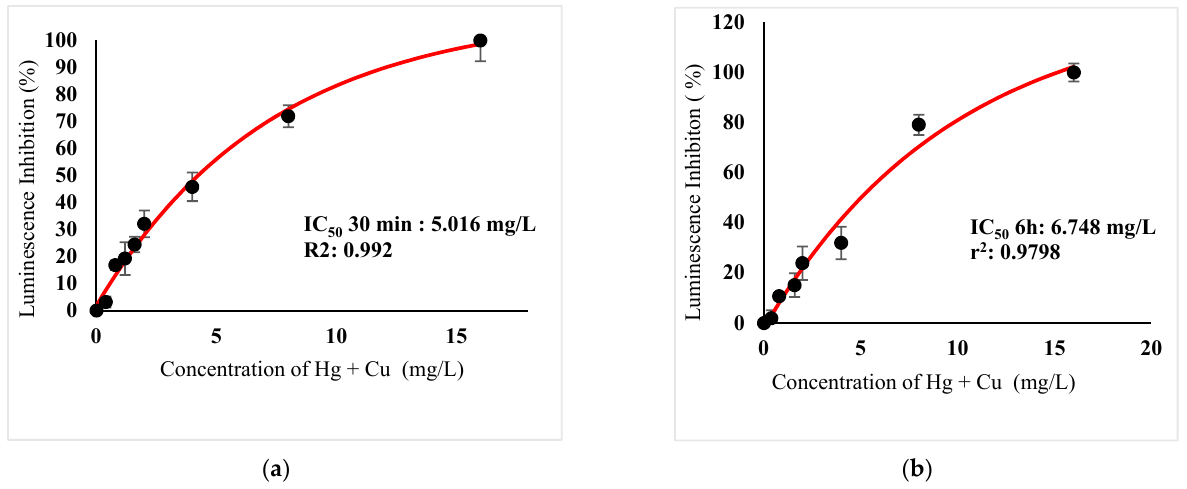
Figure 9. ( a ) Acute and ( b ) Chronic toxicity of mixture Hg 2+ + Cu 2+ in concentration ratio of 1:1 on luminescence inhibition of Photobacterium sp.NAA-MIE. Data represent mean ± SD, n = 3.